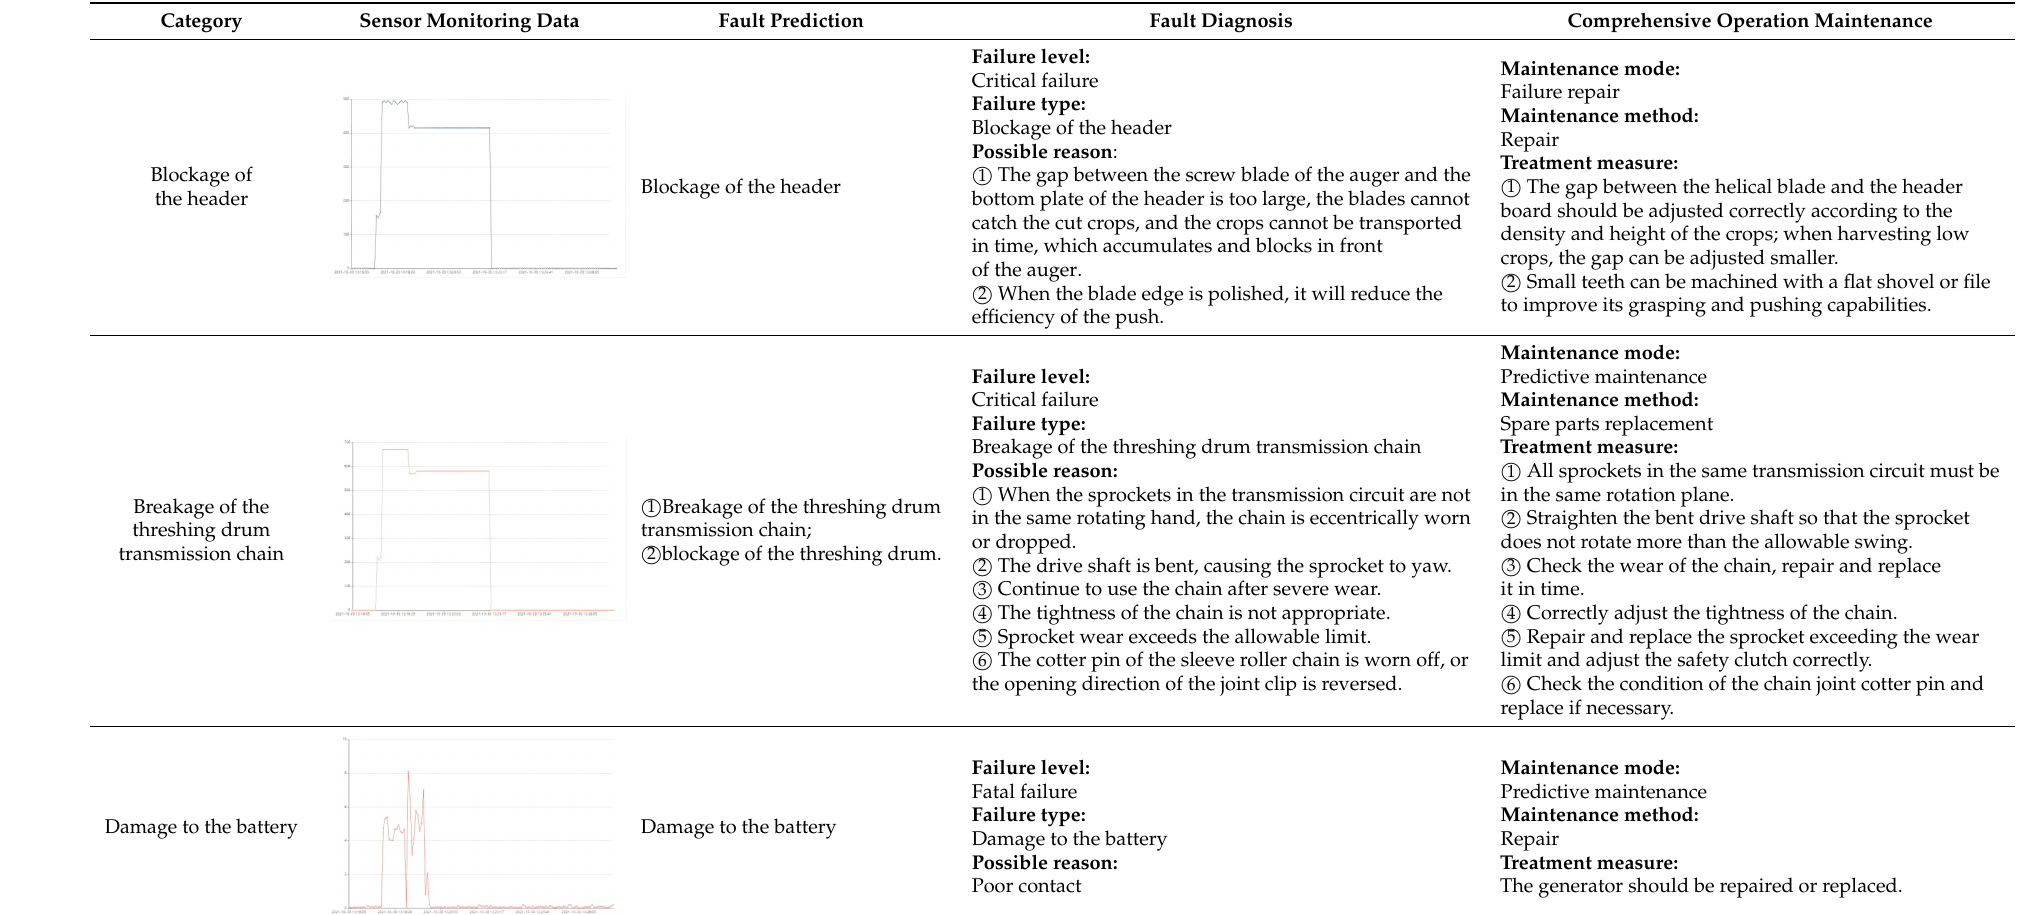
Table 1. Platform field performance test